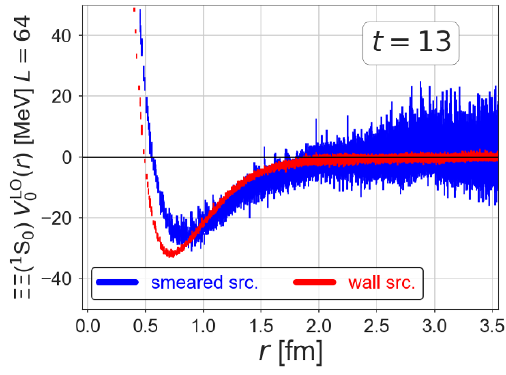
Figure 4 . A comparison of the LO (cid:4)(cid:4)( 1 S 0 ) potential V LO the smeared source (blue) at t=a = 13